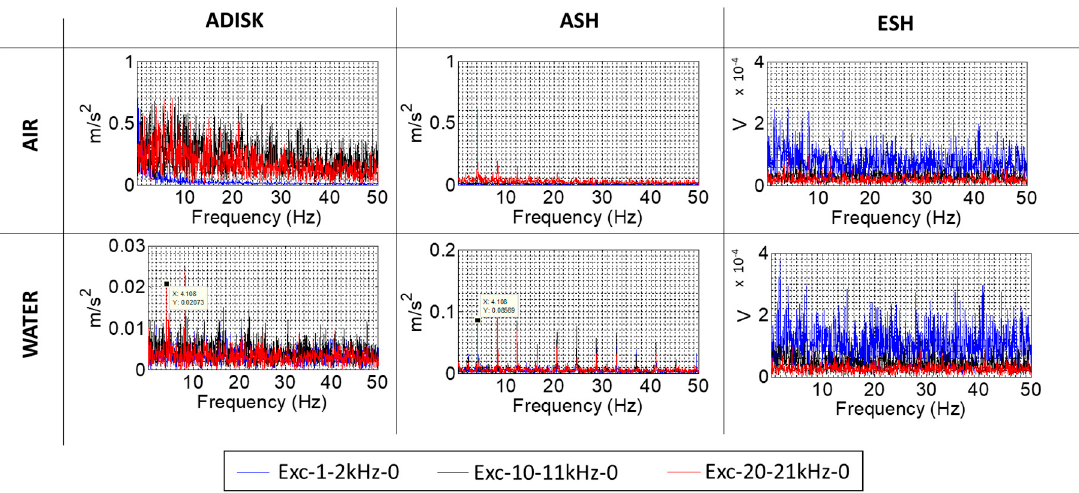
Figure 7. Amplitude demodulation for the sensors on the rotating frame and the excitation without any modulating frequencies. Rotating case ( f f = 4.1 Hz).